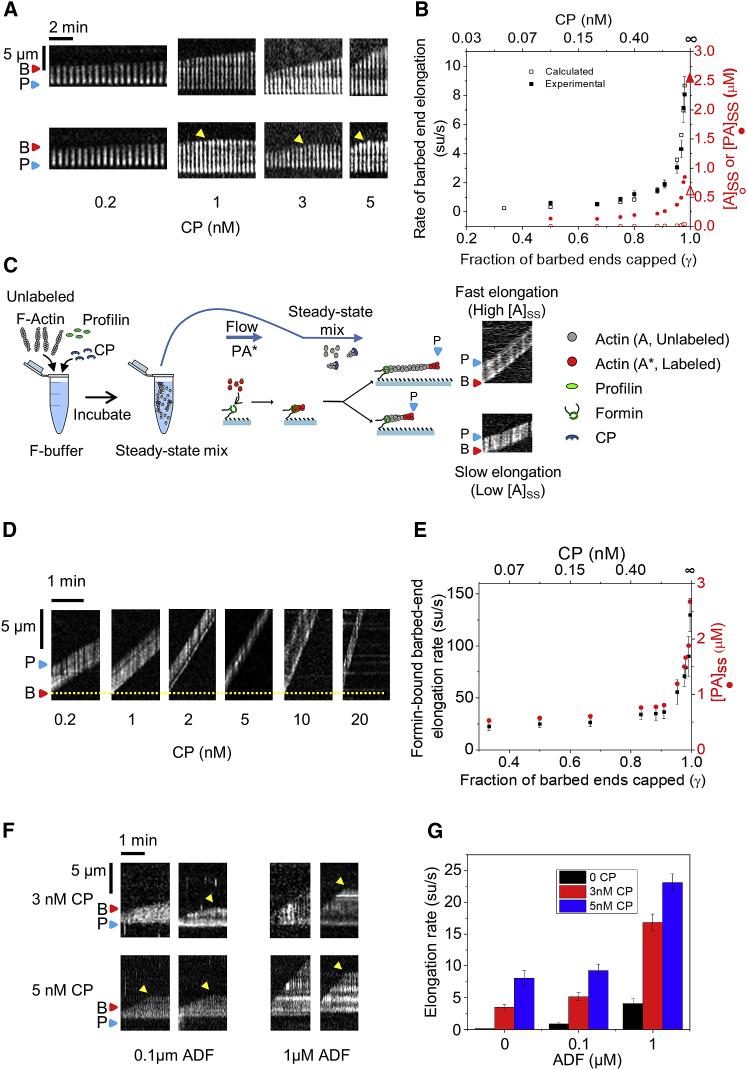
CP Increases Barbed-End Elongation Rate in Synergy with ADFExperimental conditions are as in Figure 2 except ADF replaced by CP. Tracer barbed ends were exposed to a flow containing pre-assembled 5 μM F-actin (Alexa 488 labeled), 3 μM profilin, and CP.(A) Representative kymographs of free barbed ends elongating (two for each condition). Arrest of growth by capping is indicated by yellow arrows. P, blue triangles, pointed ends; B, red triangles, barbed ends. See Figure S2.(B) Rate of barbed-end elongation versus CP concentration: experimental data (black) are plotted versus the calculated rate of tracer elongation (see Equations 7 and 8; STAR Methods) and the corresponding steady-state concentrations of profilin-actin [PA]SS (red closed circles) and free G-actin [A]SS (red open circles; see Equations 5 and 6).The values of [A]SS and [PA]SS at 100% capping are indicated as closed and open triangles, respectively.(C) Sketch of the setup to measure the amount of steady-state ATP-monomers as a function of CP concentration using formin-bound barbed ends. Tracer filaments are nucleated by exposing anchored formins to profilin and labeled actin (Alexa 488). These tracers are then exposed to steady-state solution containing unlabeled actin. The labeled segment of the filament appears to move away as unlabeled monomers are added by the formin at point of anchoring. Example kymographs show fast/slow elongation as indicators of high/low values of the steady-state amount of polymerizable actin monomers ([PA]SS+[A]SS).(D) Representative kymographs of barbed ends elongating from anchored formins (yellow dotted line). F-actin in the flow was unlabeled, letting the labeled pointed-end region of tracer filaments move away as insertional polymerization occurs at formin-bound barbed end.(E) Rate of formin elongation versus CP concentration (black closed circles) and corresponding steady-state concentrations of profilin-actin [PA]SS (red closed circles).(F) Representative kymographs (two for each condition) of tracer barbed ends growing in the presence of CP and ADF.(G) Diagram representing the synergy between CP and ADF in enhancing steady-state growth of individual filaments. Error bars represent SD. Each data point was averaged from at least 50 filaments over three experiments (n > 50).All elongation rates in (B) (except at γ = 0.75) are statistically significant (p < 0.05; two-sample t test) compared to the rate at γ = 0.5. All elongation rates in (E) (except at γ = 0.5 and 0.75) are statistically significant (p < 0.05; two-sample t test) compared to the rate at γ = 0.33. All elongation rates in (G) were found to be statistically significant compared (p < 0.05; two-sample t test) to control (0 ADF and 0 CP).